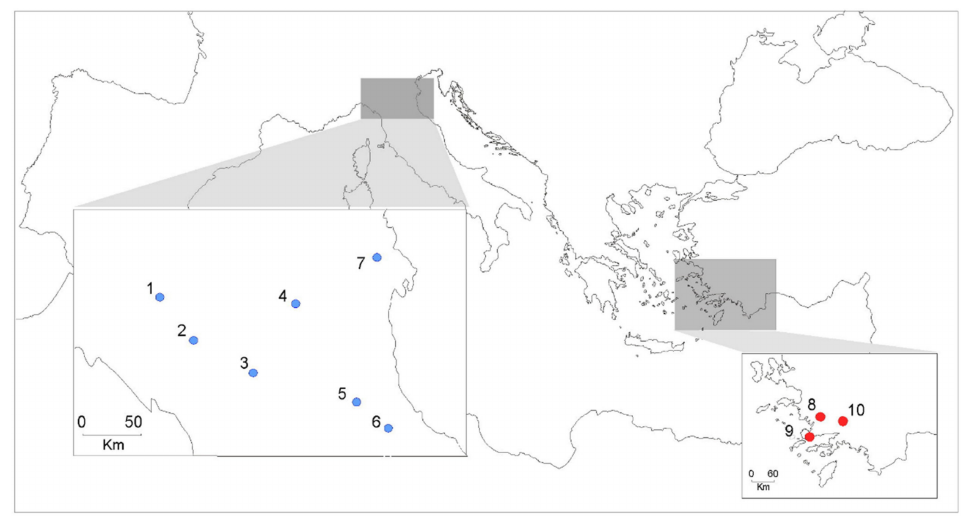
Figure 1. Map showing the location of the Culex pipiens samples used in this study. Population name and geographical coordinates are shown in Table 1. Blue and red dots represent the sampling sites from Italy and Turkey,